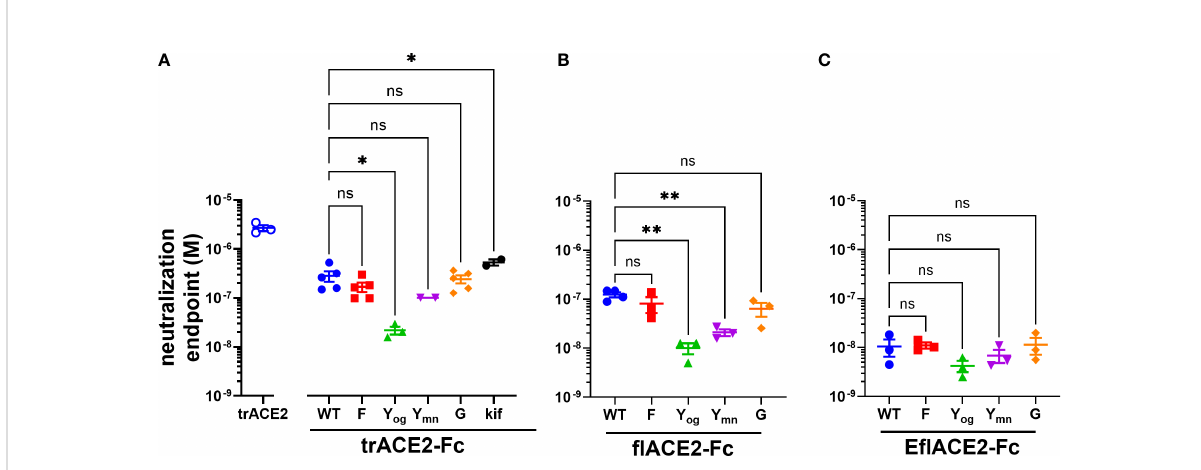
FIGURE 4 (A – C) SARS-CoV-2 neutralization potency of ACE2-Fc fusion proteins is increased by both the ACE2 scaffold and the H429Y Fc mutation. Neutralization potencies of the ACE2 enzymatic ectodomain polypeptide (trACE2) and the three formats of ACE2-Fc-WT fusion and variant proteins were determined by titration of the cytopathic effect to endpoint in a micro-neutralization assay. The fusion proteins were (A) trACE2- Fc-WT, (B) fl ACE2-Fc-WT and (C) E fl ACE2-Fc-WT, incorporating triple mutation of ACE2 engineered (43) for enhanced af fi nity to RBD and their Fc variants (Eu numbering), E430G, G; H429F, F; H429Y oligomers on SEC, Yog; and H429Y monomers on SEC, Ymn. A further variant trACE2- Fc fusion protein is the glycan-modi fi ed trACE2-Fc-kif produced in the presence of kifunensine. Mean ± SEM, one-way ANOVA with Dunnett ’ s